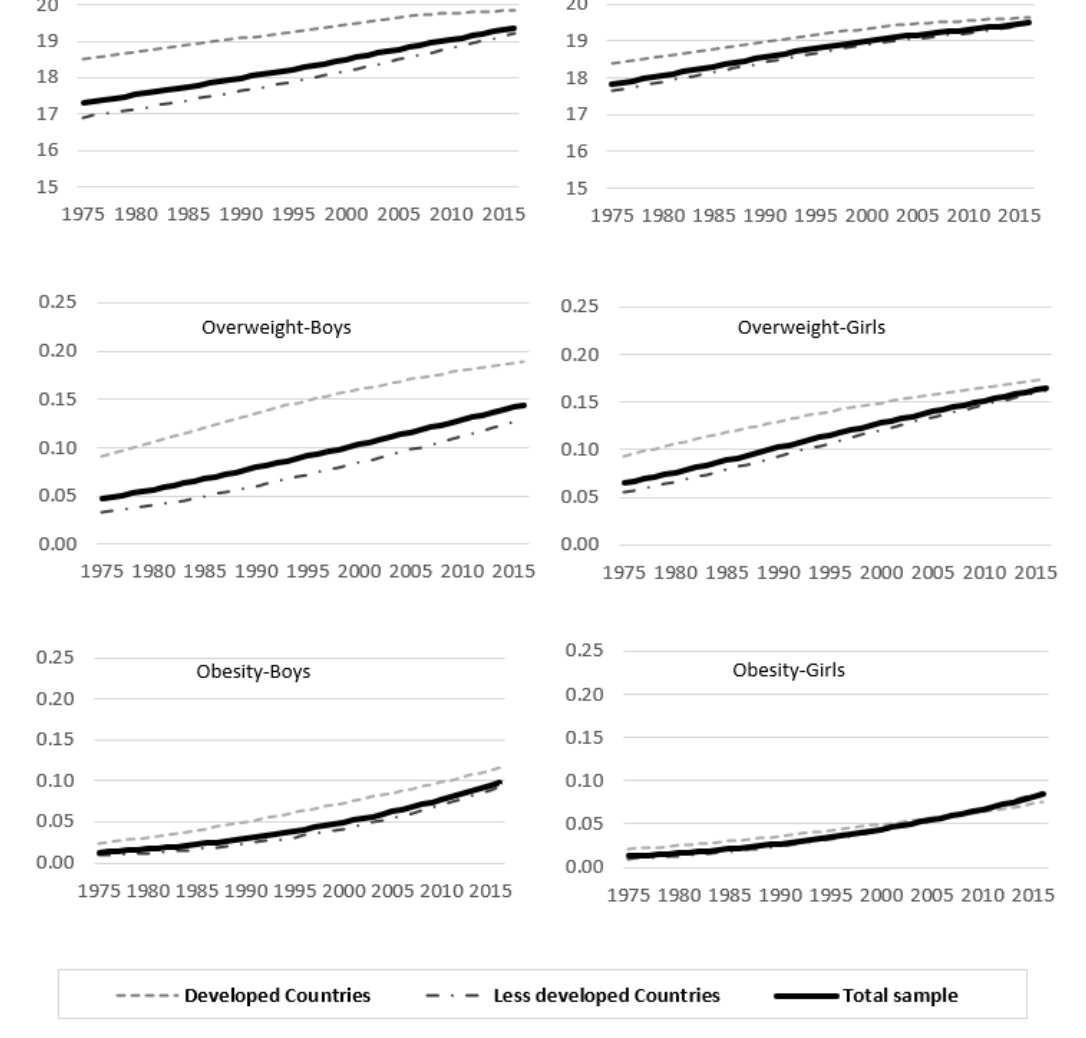
Figure A3. BMI, overweight and obesity evolution by gender and level of development.